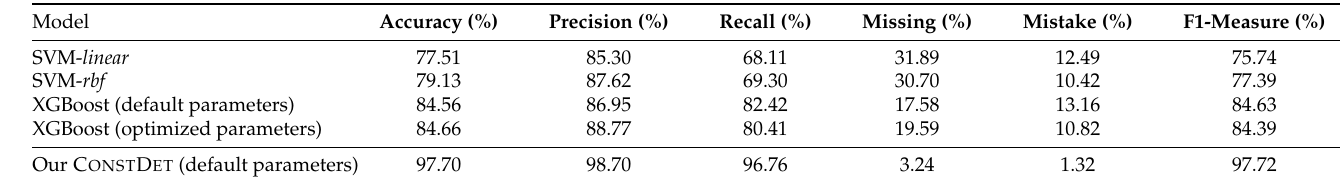
Table 7. Comparison of experimental results between the JSA method [14] and our C ONST D ET approach. We implemented the JSA method. For the JSA method, the SVM- linear , SVM- rbf , XGBoost (with default parameters), and XGBoost (with optimized parameters provided by the JSA method) models were trained and tested using our UAV dataset. The last row is the performance of our C ONST D ET approach using the default ML model parameters.